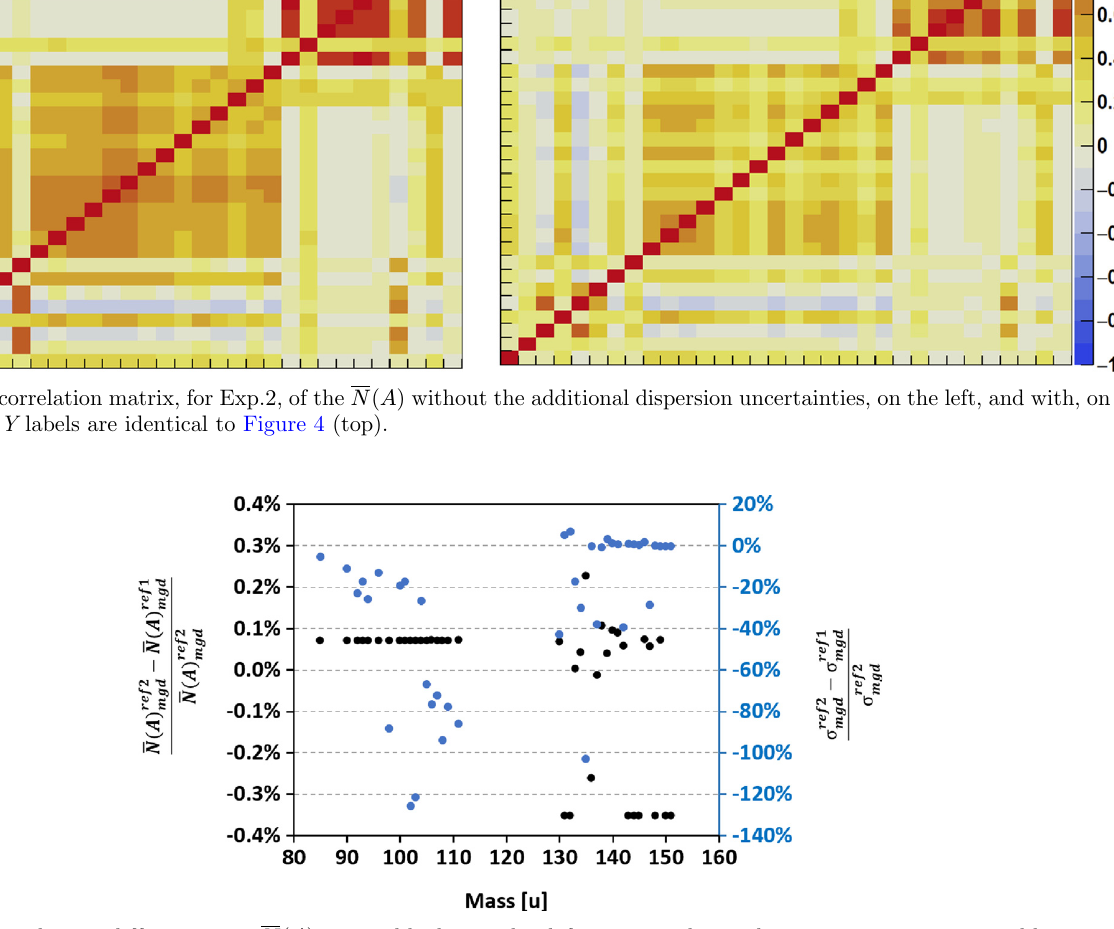
in black on the left axis, and on the uncertainty s mgd in blue on the mgd